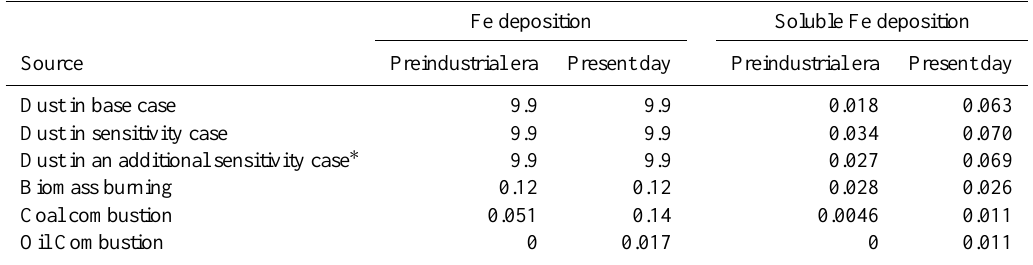
Figure 6. Ratio (%) of the soluble to total Fe deposition for mineral dust in the (a) present day from base simulations, (b) the preindustrial era from base simulations, (c) the present day from sensitivity simulations, and (d) the preindustrial era from sensitivity simulations. The formation of the amorphous Fe(OH) 3 (s) suppresses the oxalate-promoted dissolution from mineral aerosols in the base simulations, while no such effect was considered for quasi-light-induced reductive dissolution in the sensitivity simulation (i.e., f 3 = 1). Table 4. Annual deposition rates of total and soluble Fe (TgFeyr − 1 ) from different sources to the ocean in the base, sensitivity, and additional sensitivity